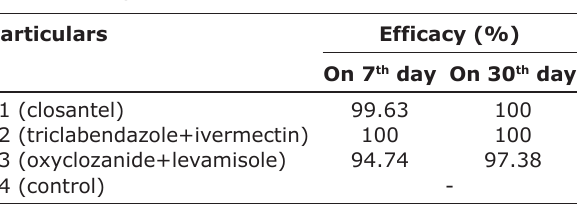
Table-4: Efficacy of different anthelmintics drugs in fasciolosis of goats.